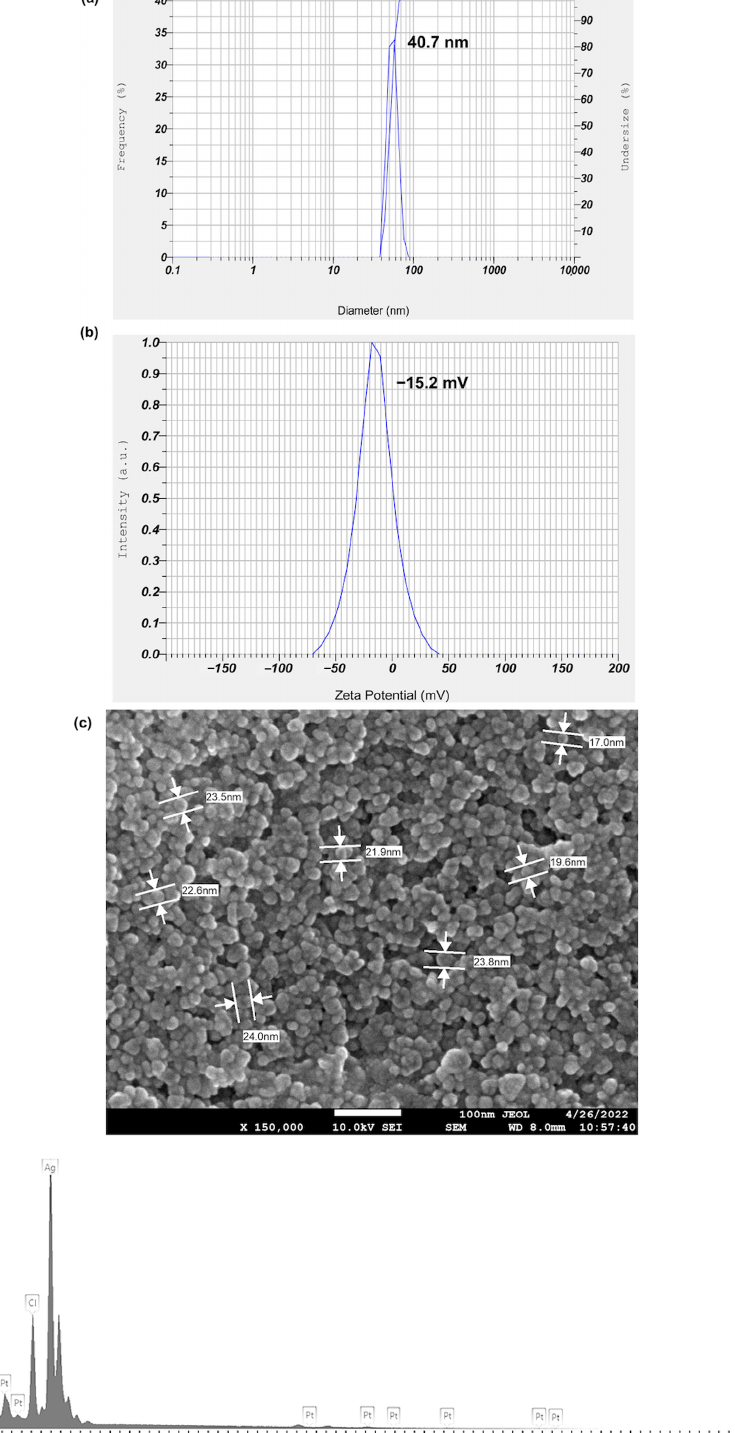
Figure 2. Dynamic light scattering (DLS) ( a ), zeta potential ( b ), FE-SEM image ( c ) and EDX ( d ) analyses of MLE-AgNPs.